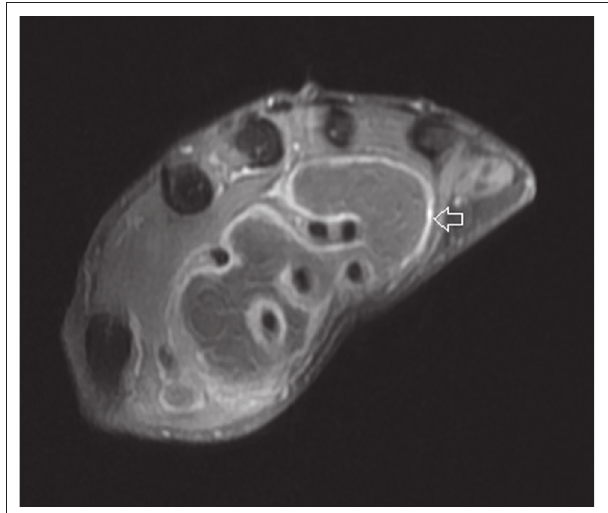
FIGURE 5: Postcontrast axial T1-weighted image reveals peripheral rim-like contrast enhancement